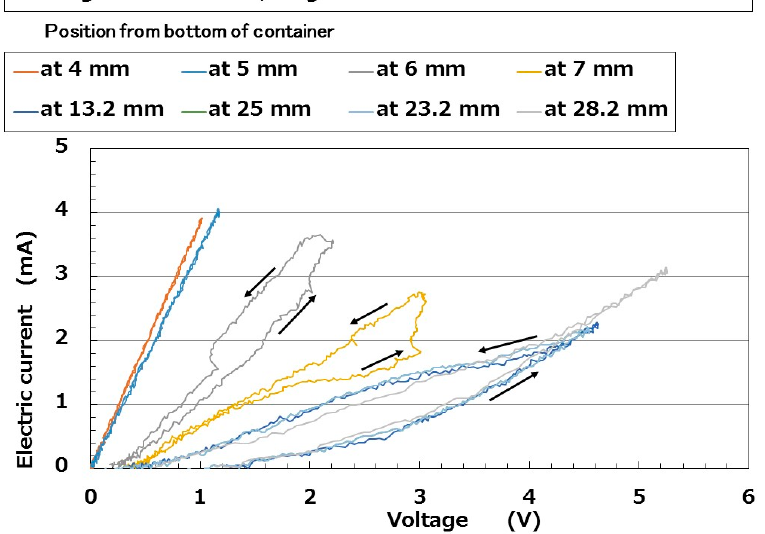
Figure 7. Relation between voltage and electric current of MCF rubber liquid for moving electrodes with installation of a magnet at the bottom of the outer wall of the container regarding Figure 6.